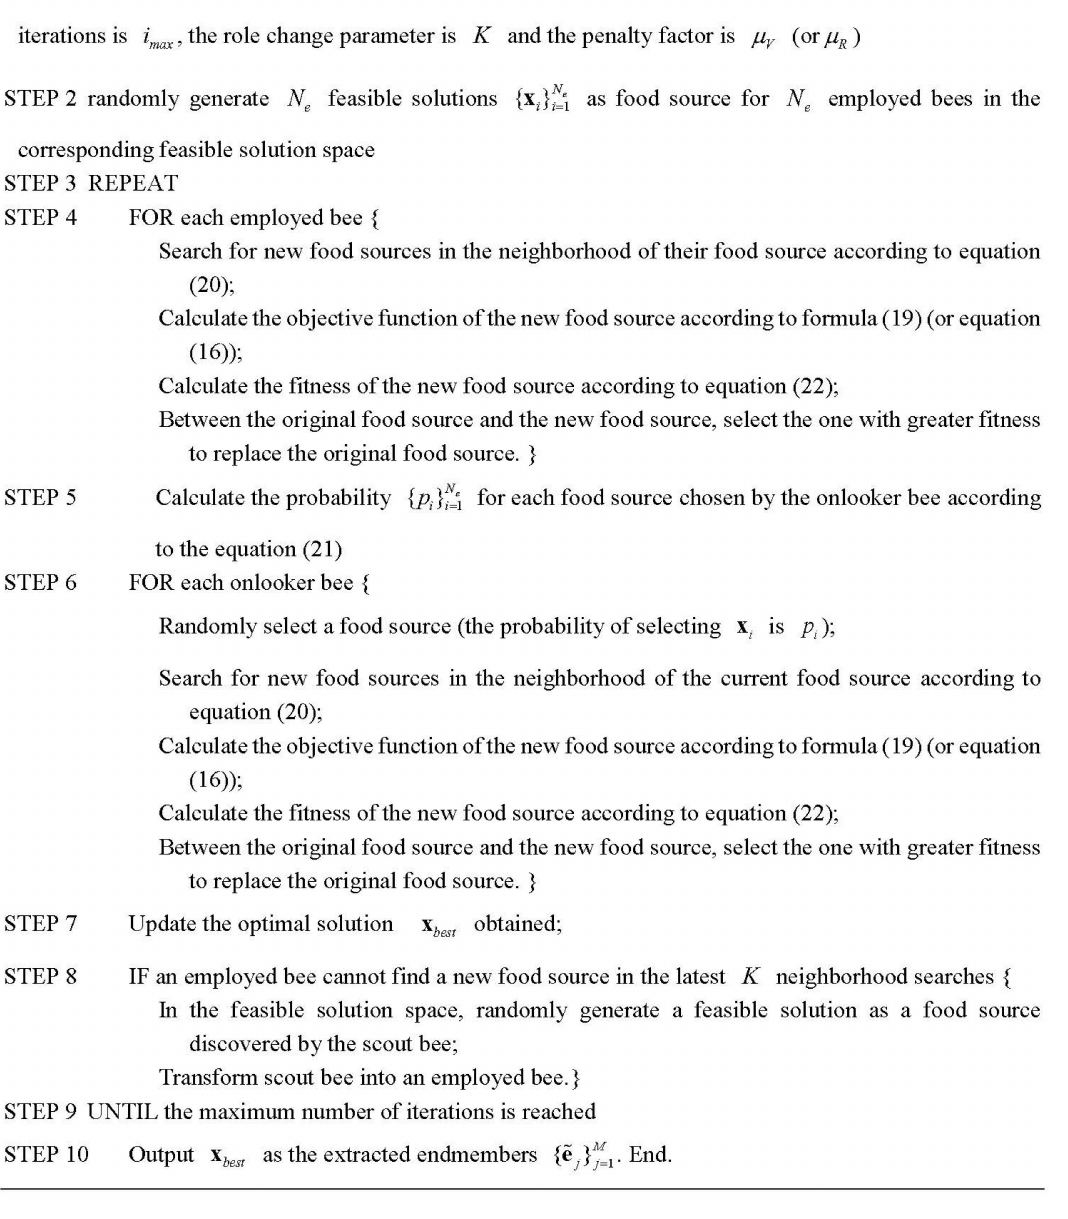
Figure 2. Pseudo of